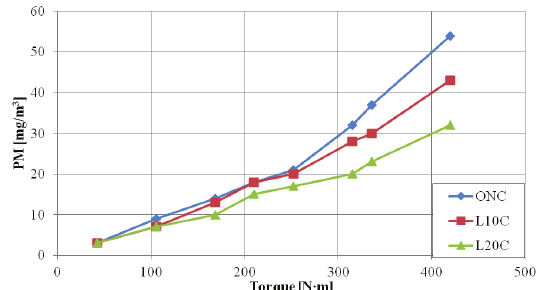
Fig. 11. PM for injection timing A and n = 2000 rpm